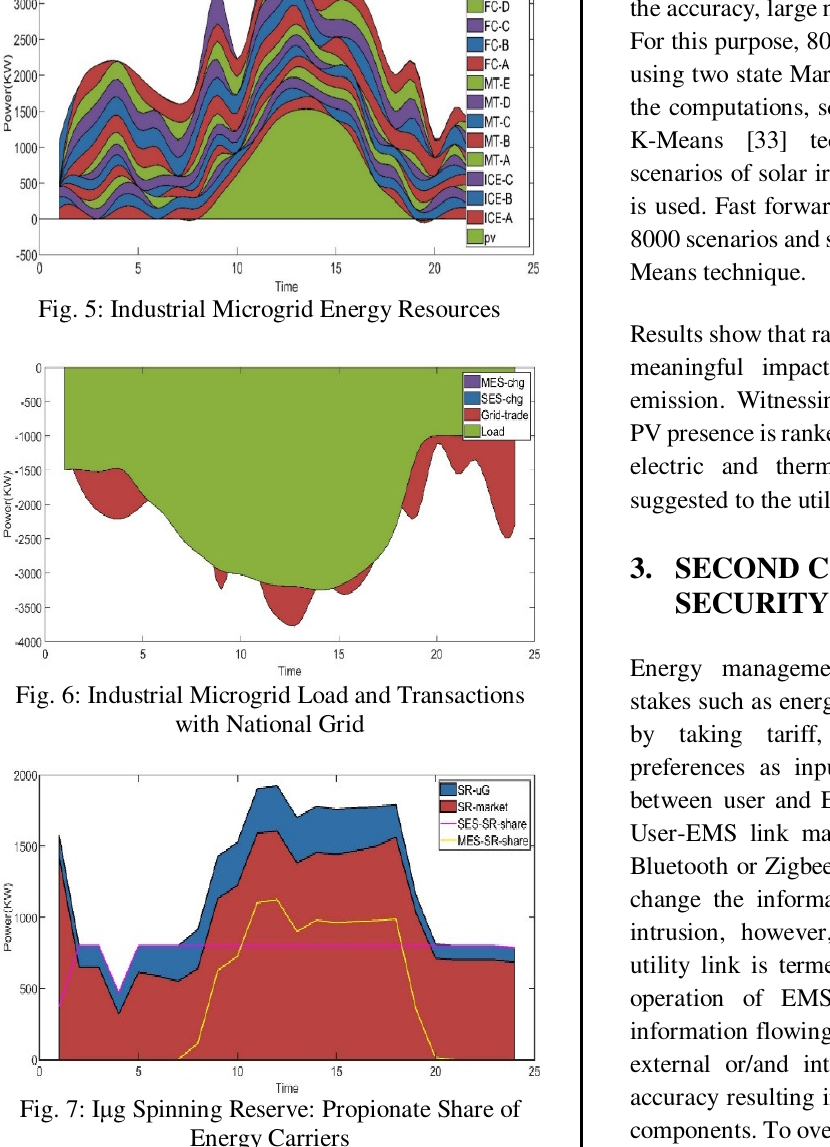
Fig. 7: I μ g Spinning Reserve: Propionate Share of Energy Carriers